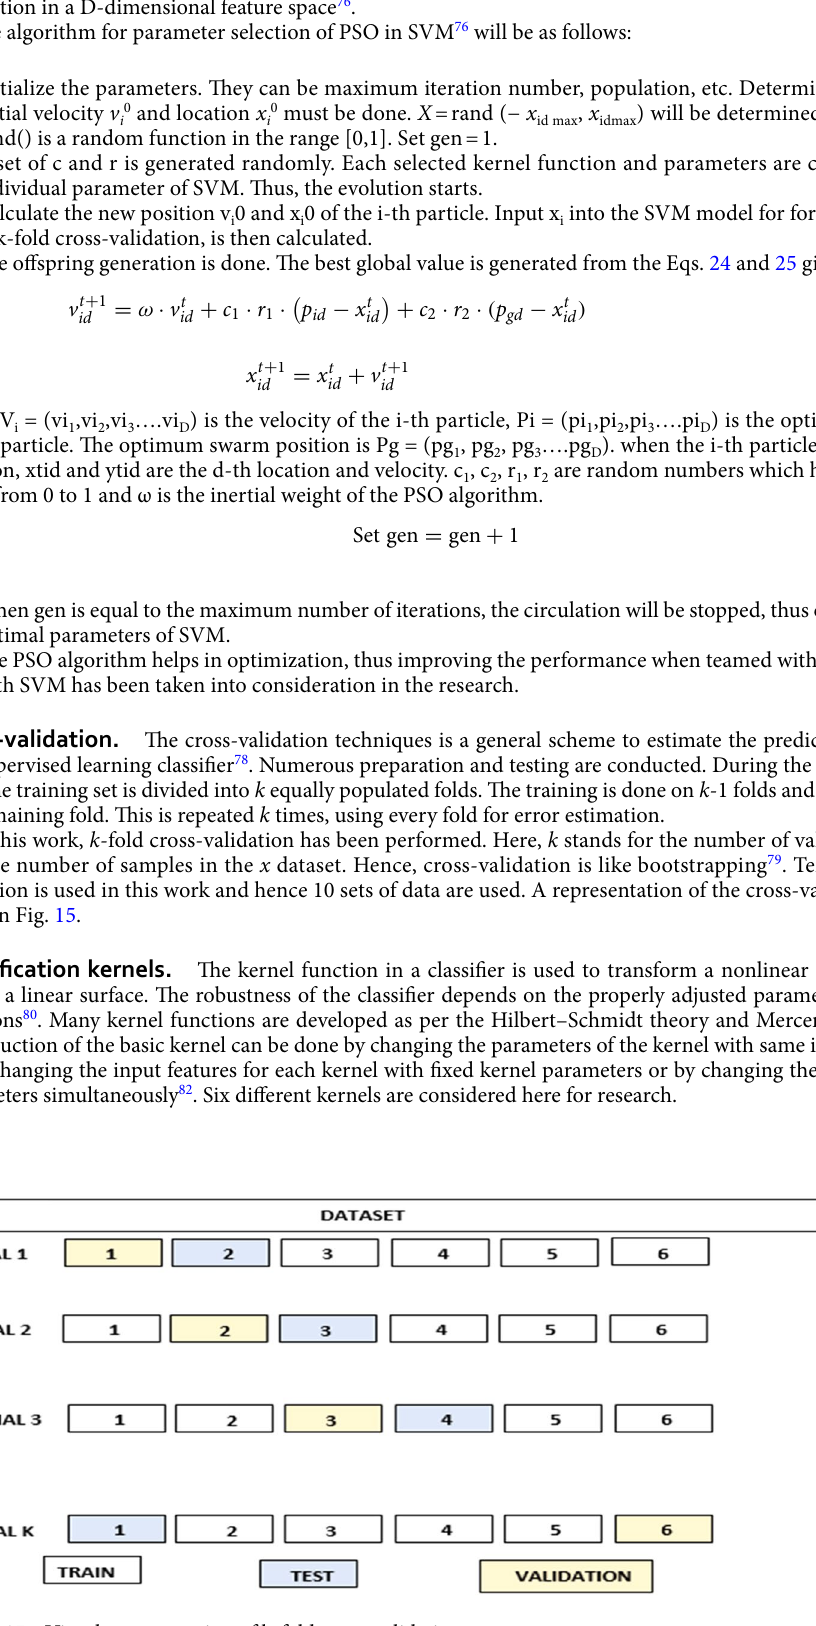
Figure 15. Visual representation of k-fold